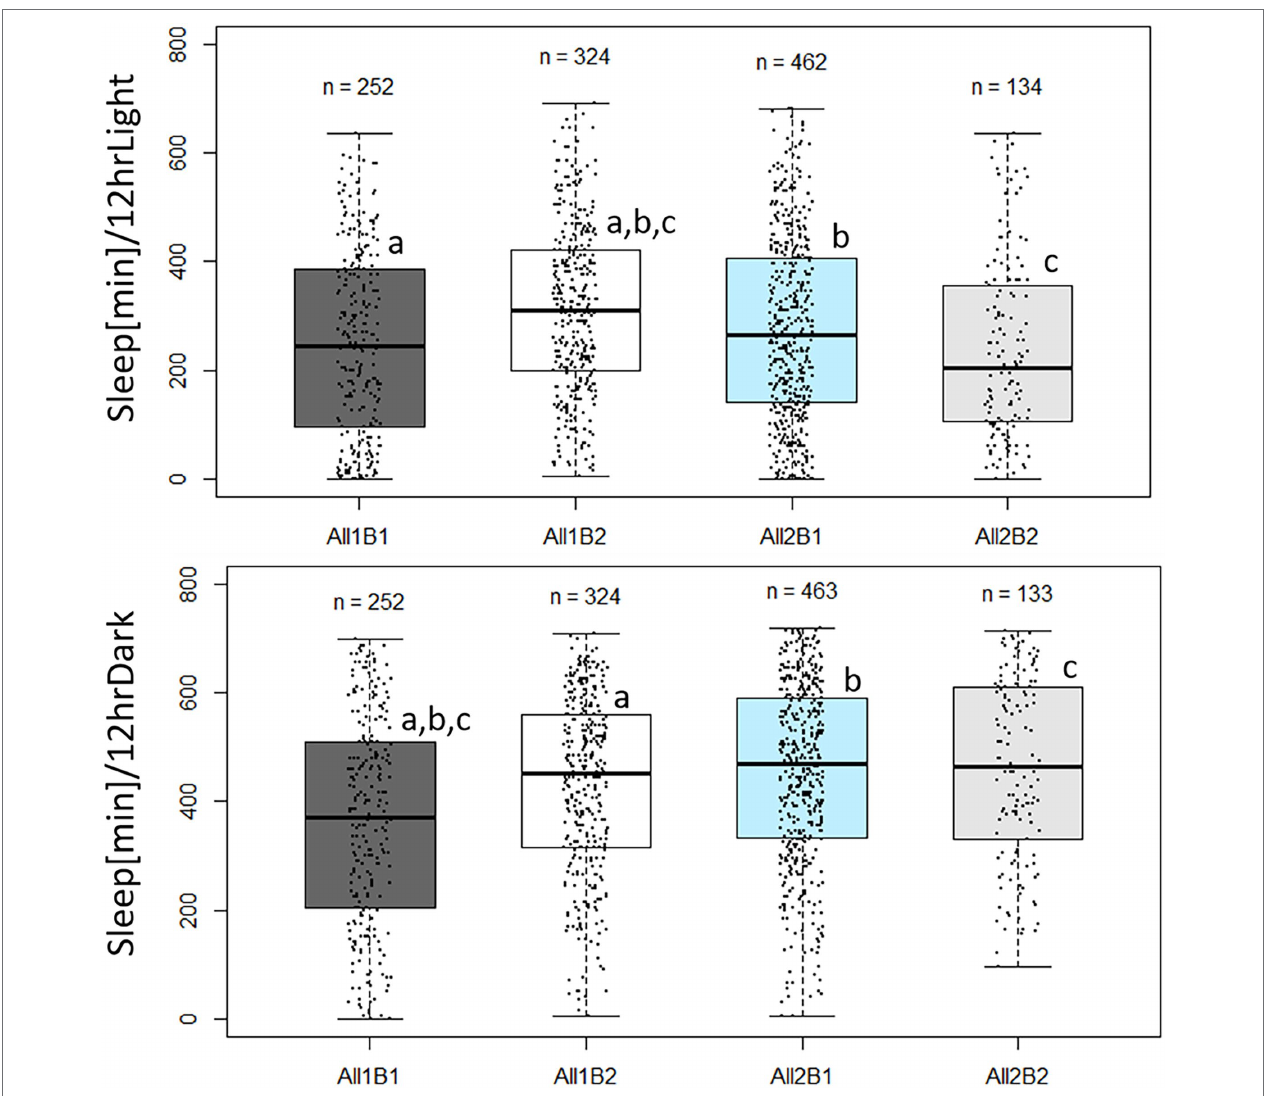
FIGURE 8 | Sleep duration in cry haplotypes. Boxplot showing minutes of sleep during photophase ( upper panels ) and scotophase ( lower panels ). The middle line represents the median, and the box indicates the interquartile range (IQR). The whiskers signify 1.5 × IQR. The number of flies in each haplotype is indicated. Dots represent individual values. Sleep was quantified during the third day in LD. Letters indicate significant post-hoc comparisons (a, b, c, p < 0.05). Photophase sleep: All1B1 245 min ± 10.6 min (median ± SEM); All1B2 310 min ± 8.6 min; All2B1 265 min ± 7.8 min; and All2B2 205 min ± 14.0 min. Scotophase sleep: All1B1 370 min ± 12 min; All1B2 452.5 min ± 9 min; All2B1 470 min ± 7.7 min; and All2B2 465 min ± 14.5